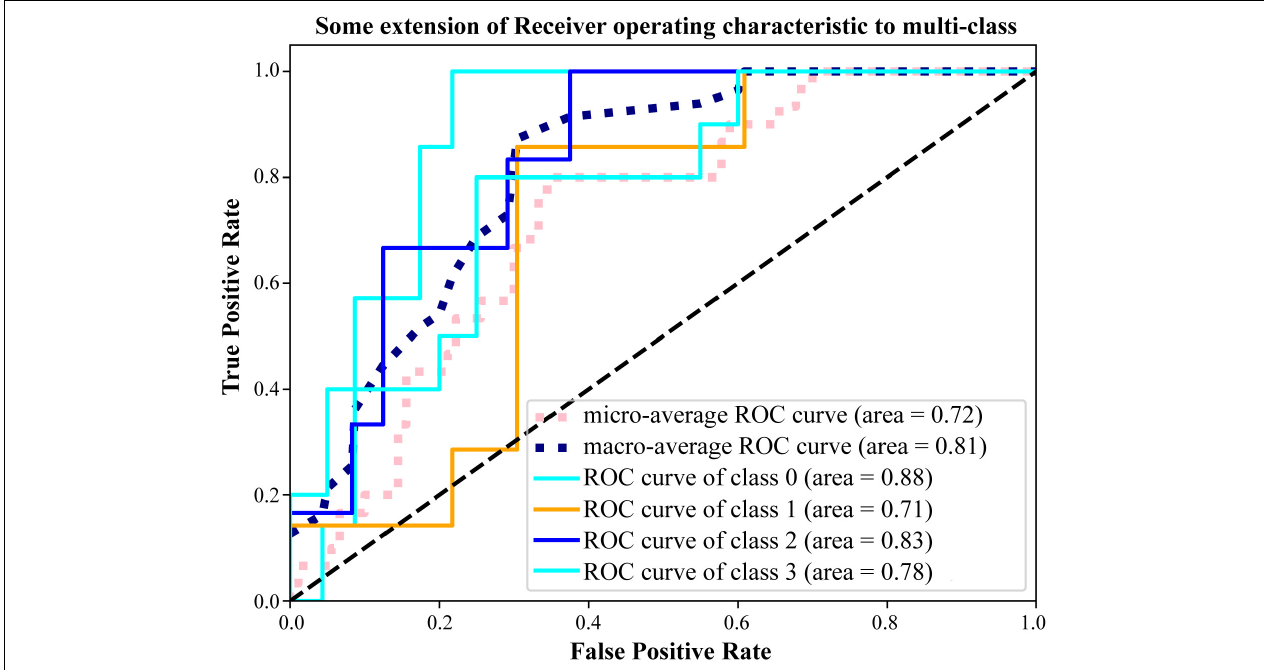
FIGURE 6 | Validation the prediction accuracy of the model. ROC analysis of the four hub metabolites by micro and macro-average ROC machine-learning algorithms for multi-class variables. Class 0 ∼ 3 represented the Co-no, Co-um, IVL-no, and IVL-re groups, respectively. AUC value was applied to characterize the model